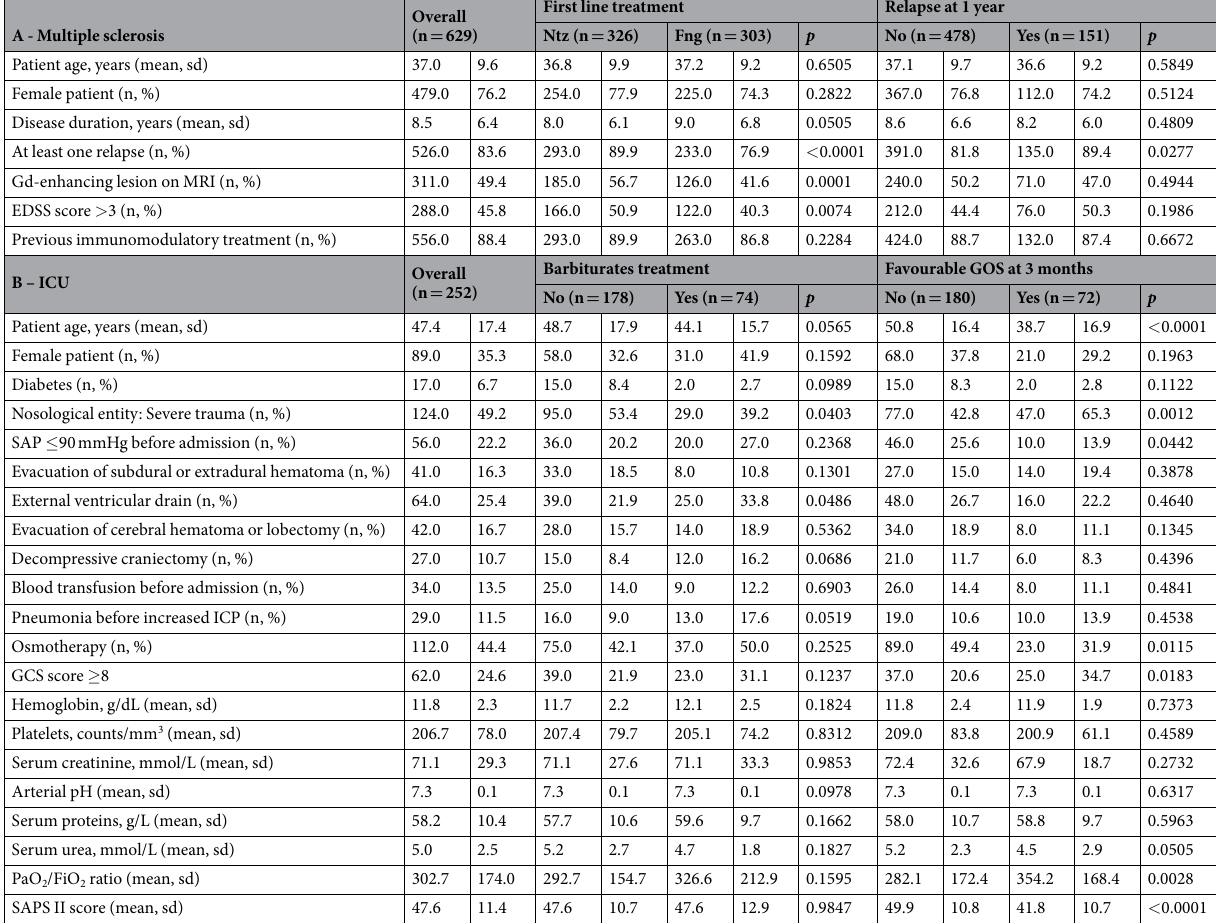
Table 3. Baseline characteristics of patients of the two studied cohorts. Ntz: Natalizumab, Fng: Fingolimod, Gd: Gadolinium, MRI: Magnetic Resonance Imaging, EDSS: Expanded Disability Status Scale, SAP: